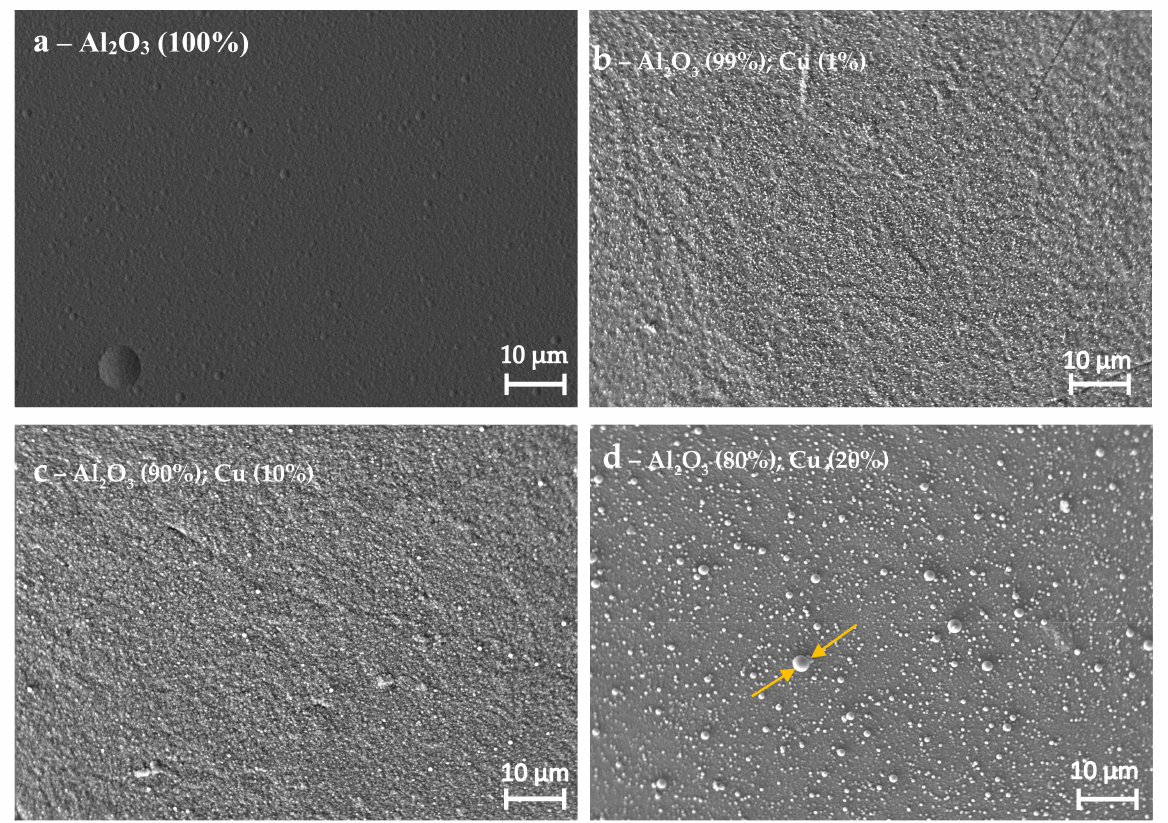
Figure 5. Micrographs of the fabricated coatings.